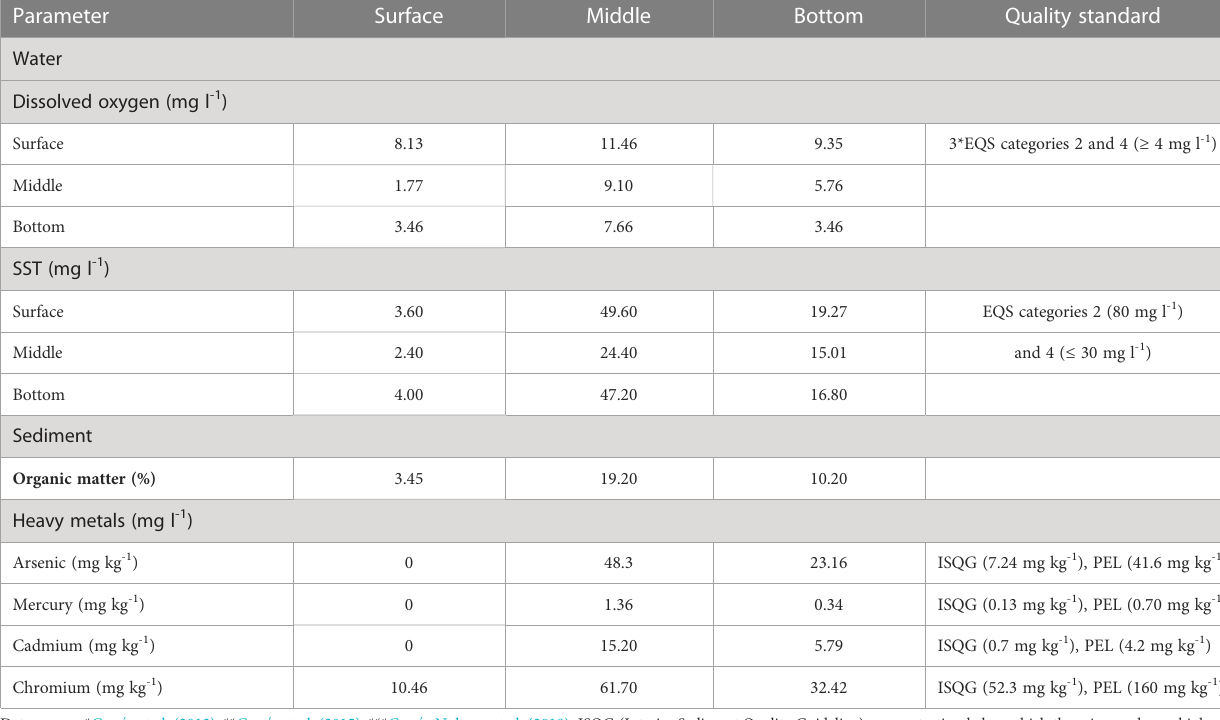
TABLE 3 Water and sediment quality values in Samanco Bay during the period 2005-10, 2014-15, and November 2018.